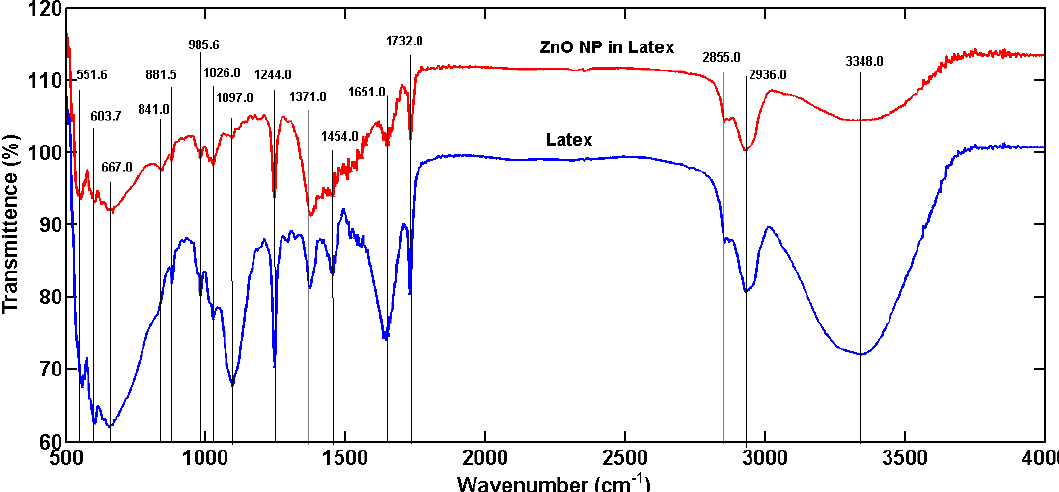
Figure 5. Fourier Transform Infrared (FTIR) spectra recoded from KBr pellets containing dry powder samples of ZnONP-GS in latex (red) and milky latex (blue) from C. gigantea.